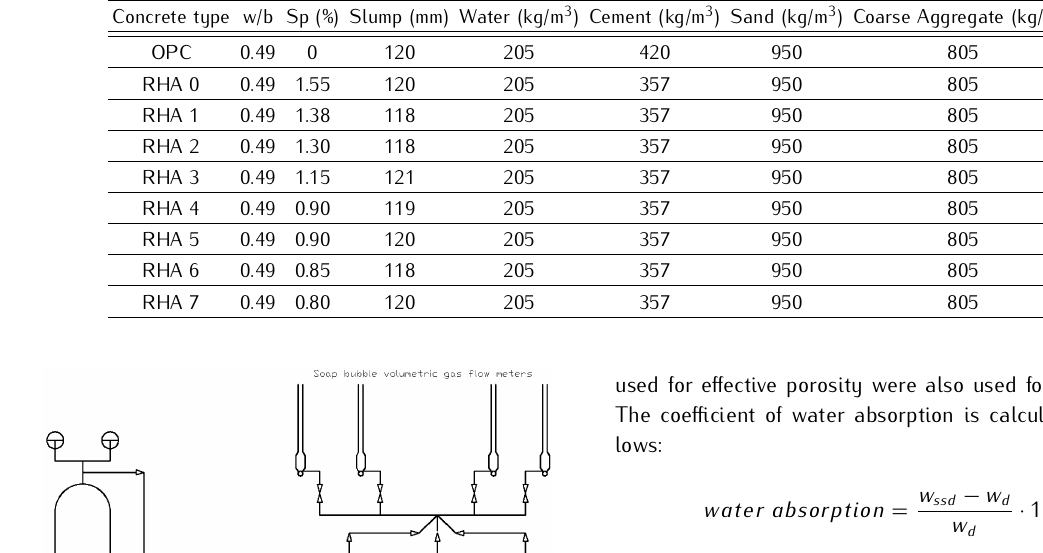
Table 3. Mix proportion of concrete at varying grinding time.